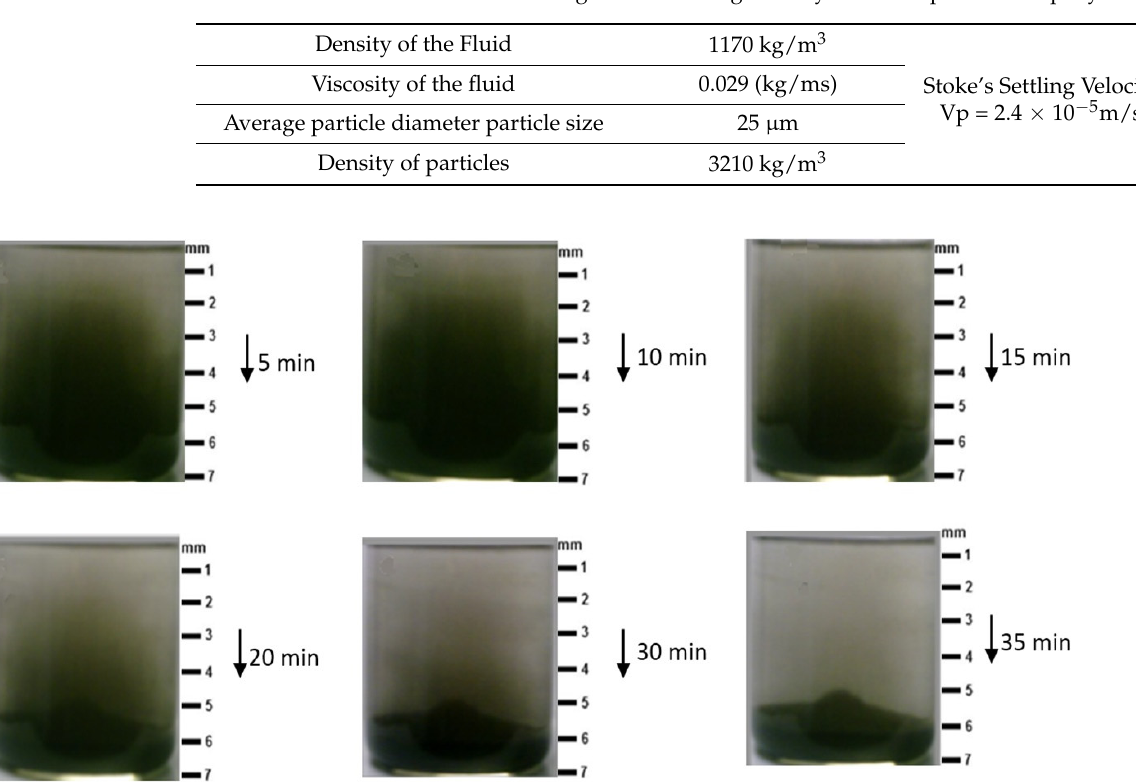
Figure 4. Schematic of the influence of increasing the number of layers on liquid polymer. 4.2. Morphology SEM photomicrographs and microscopic photographs were used to ensure that the ceramic particles were uniformly distributed within the polymer. Figure 5 shows the mi- croscope photographs of top surfaces of the polymer composite microstructure at differ- ent wt.% of the ceramic material. The microscopic photographs clearly show the bonding between each layer of the polymer composite with different contents of SiC wt.%. Figure 6 shows SEM photomicrographs with two magnifications and different contents of SiC wt.%. The figure reveals that the SiC particles are completely dispersed in the polymer. In addition, high ceramic content was found at the upper layer of the kraft paper due to the action of gravity. At a low SiC concentration (6% wt.%), the ceramic particles were dis- persed in the sample, and larger particles were concentrated on the kraft paper (see Figure 6a). As the ceramic content increased, particles of SiC were dispersed uniformly, and larger particles were concentrated above the kraft paper (see Figure 6b). This may be due to the difference in density between ceramic and epoxy, making the SiC tend to settle in